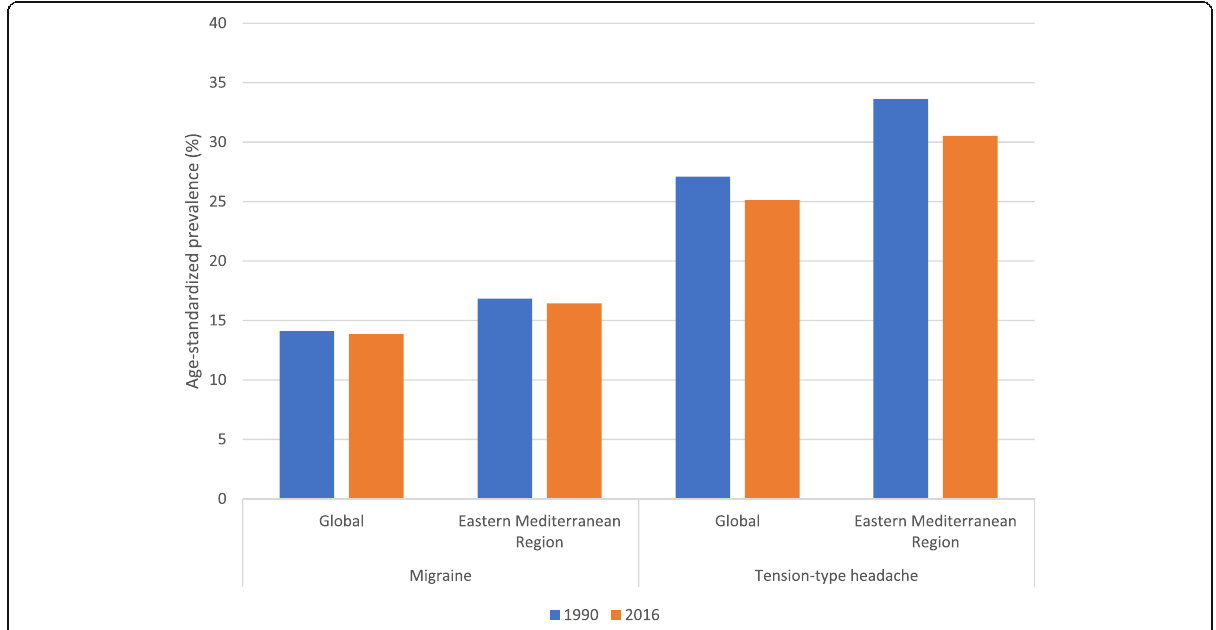
Fig. 1 Change in age-standardised prevalence rates from 1990 to 2016. Abbreviations: TTH, tension-type headache; EMR, Eastern Mediterranean